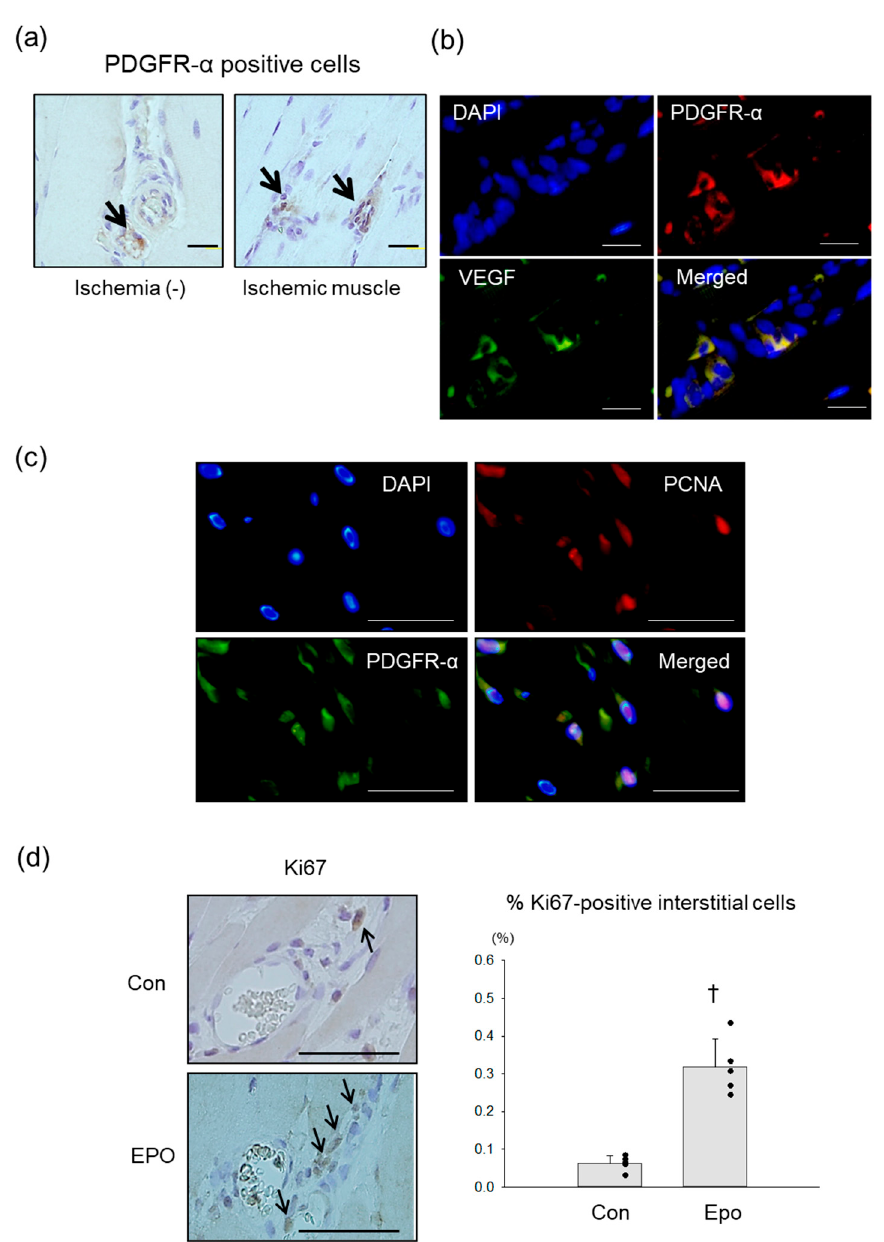
Figure 4. Proliferation of mMSCs in rat ischemic hindlimbs treated with Epo. ( a ) mMSCs positive for PDGFR- α (brown) were detected in the interstitial area of rat hindlimb muscles with and without ischemia. Arrows indicate the PDGFR- α -positive cells. Bar = 20 µm. ( b ) In double immuno fl uorescence, VEGF (green) was observed in mMSCs positive for PDGFR- α (red) in ischemic limbs. Nuclei were stained with DAPI (blue). Bar = 50 µm. ( c ) Proliferating cell marker, PCNA (red in the nucleus), was detected in the nuclei (DAPI, blue) of some of the mMSCs positive for PDGFR- α (green). Bar = 50 µm. PCNA, proliferating cell nuclear antigen. ( d ) Immunohistochemistry was performed with Ki67 antibody to evaluate the proliferating cells. Left images, the Ki67-positive cells (brown) in the nucleus were mainly detected in the stromal area around the vessels. Arrows indicate Ki67-positive cells. Bar = 200 µm. Right graph, comparison of the proliferating cell index between the ischemic limbs treated with and without Epo. N = 5. † p < 0.001.